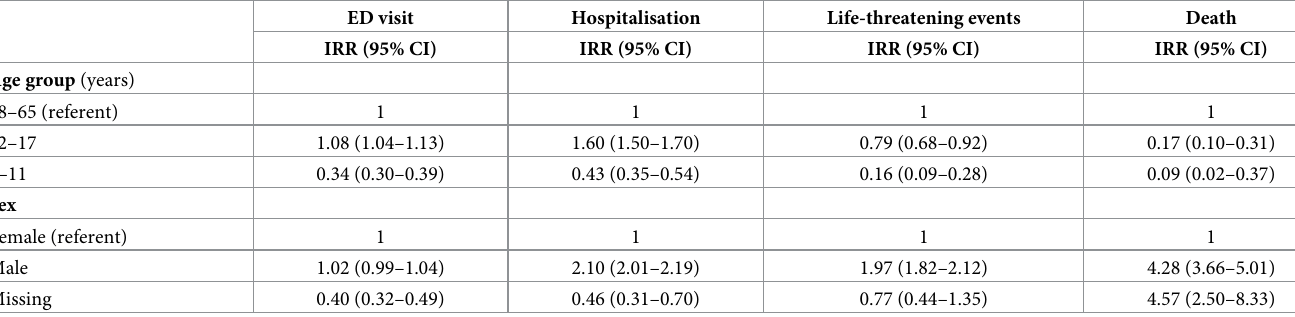
life-threatening events or death, but the overall reported rates were very low. The low rates of reported sAEFI suggest that BNT-162b2 vaccination is safe in children. As COVID-19 becomes endemic and the cumulative risk of long-COVID increases, safety data from surveil- lance databases such as VAERS are helpful, and must be utilized to assuage parental anxiety, assist primary care physicians to adequately inform their patients, and for public health offi- cials to promote trust in vaccines. Accurate and timely articulation of these adverse events data are paramount to dispelling misinformation or confusion. Table 3. Incidence rate ratios for reported